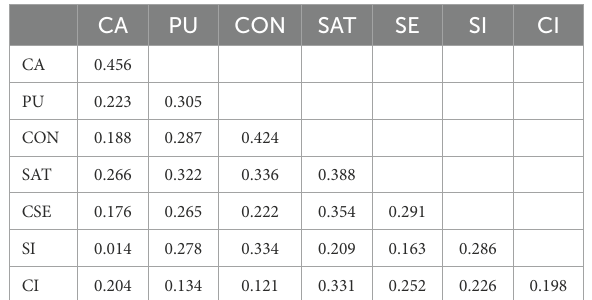
TABLE 3 Measurement model assessment.